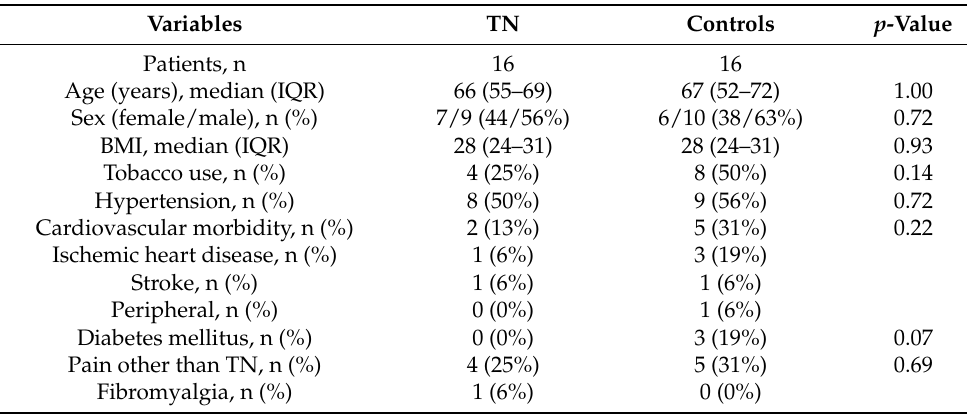
Table 1. Demographic data in TN patients and